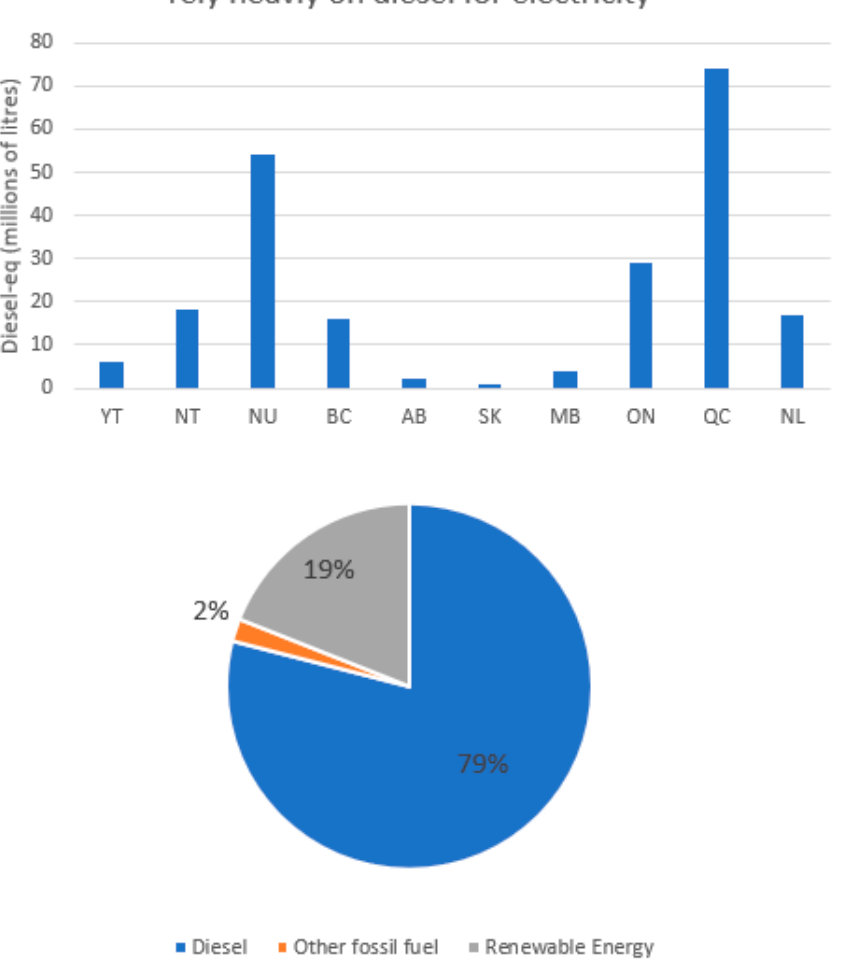
Figure 1. Remote communities in Canada, mainly Nunavut and Quebec, rely on diesel fuel for heating and electricity generation [42].